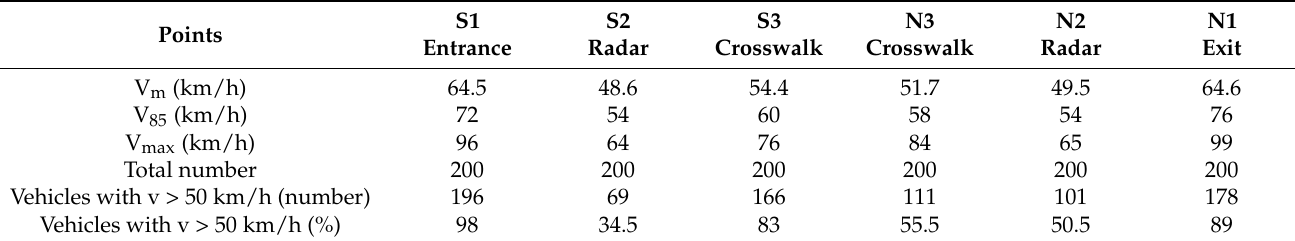
Table 2. Values of selected variables at control points in Chodor ó wka Nowa. Points